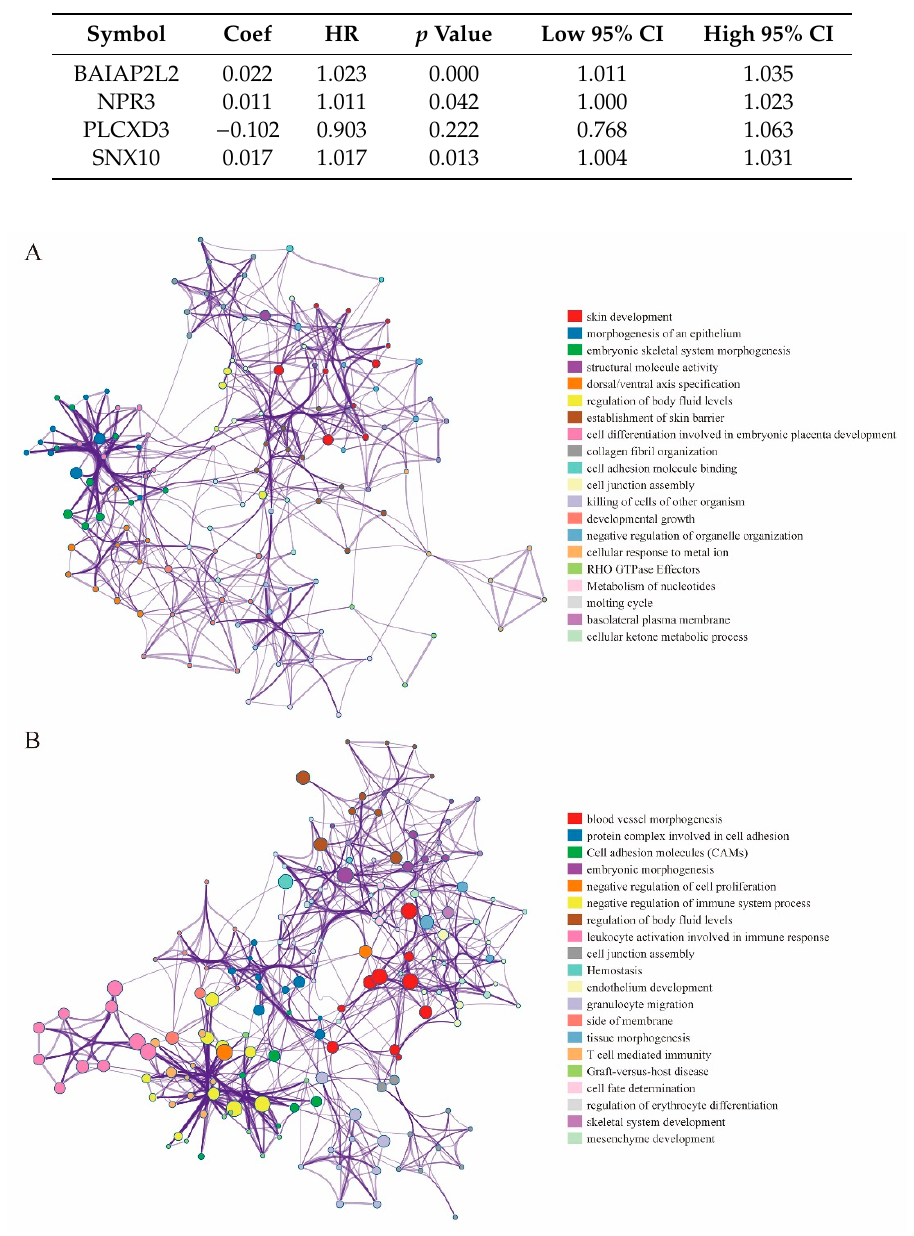
Figure 6. Pathway enrichment analysis of the upregulated and downregulated DMEGs. ( A ) The pathway enrichment results of upregulated DMEGs. ( B ) The pathway enrichment results of downregulated DMEGs. Each node represents an enriched term. The node size is proportional to the total number of genes in each gene set. The proportion of shared genes between genomes is indicated by the line thickness between nodes.